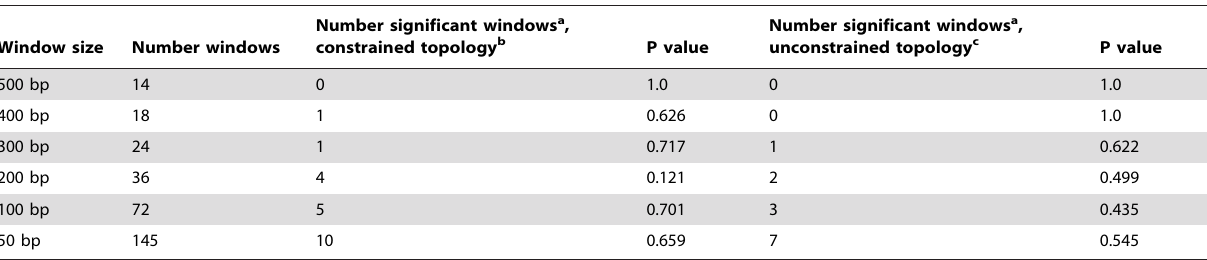
Table 1. Sliding Window Test of the Molecular Clock.